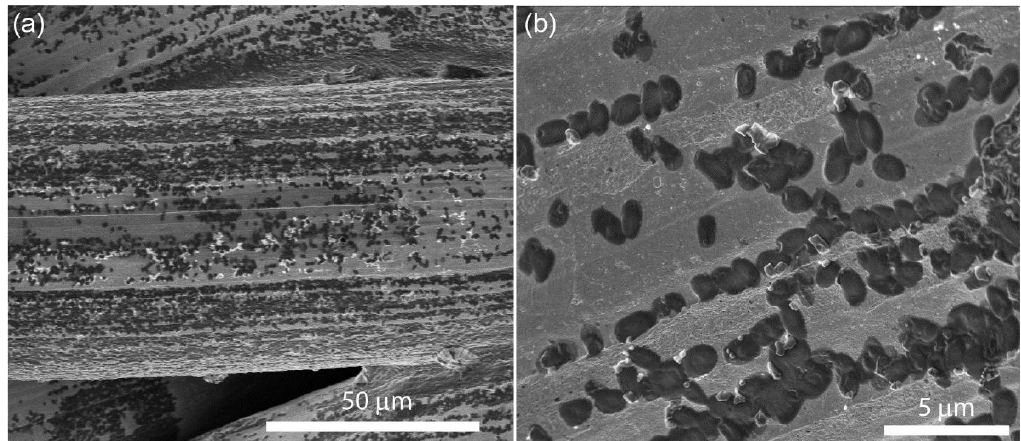
Figure 8. SEM images of E. coli placed onto Ag/SSWM surface and collected at ( a ) lower and ( b ) higher magnification. The bacteria are arranged in lines due to irregularities of wire surface.